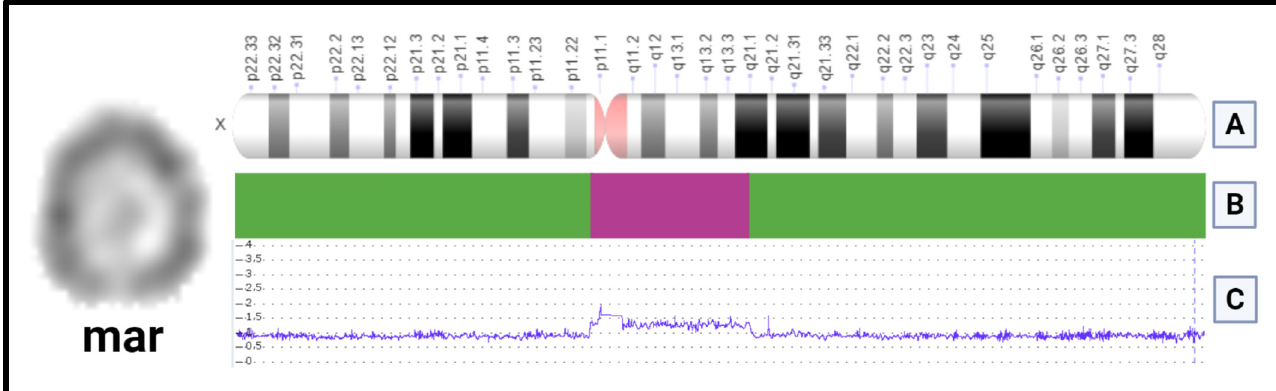
Figure 3. Diagram representing the breaking points in the sSMCT. On the left is the marker chro- mosome. ( A ) X chromosome ideogram. Provided by NCBI Genome decoration page. ( B ) The magenta bar represents the sSMCT, and the green bars the double terminal deletion. ( C ) Result of the aCGHarr[GRCh37] Xp22.33p11.21(1_5685094056687922)×1, Xq21.1(8326897882192264_156040895)×1,Xp11.21q21.1(56850941_8219226356687923_83268977)×1.5.